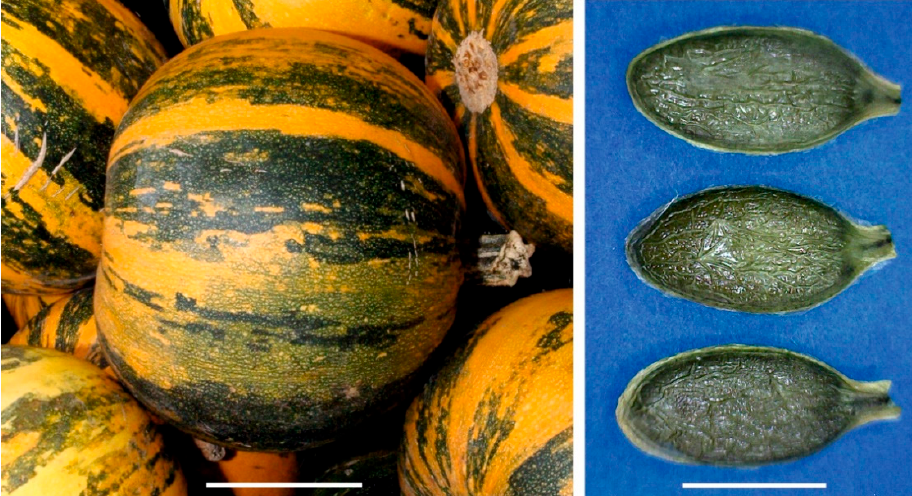
Figure 1. Fruits and seeds of Styrian oil pumpkin ( Cucurbita pepo L. subsp. pepo var. styriaca Greb.) variety Junona. Bars: left photo = 10 cm and right photo = 1 cm.